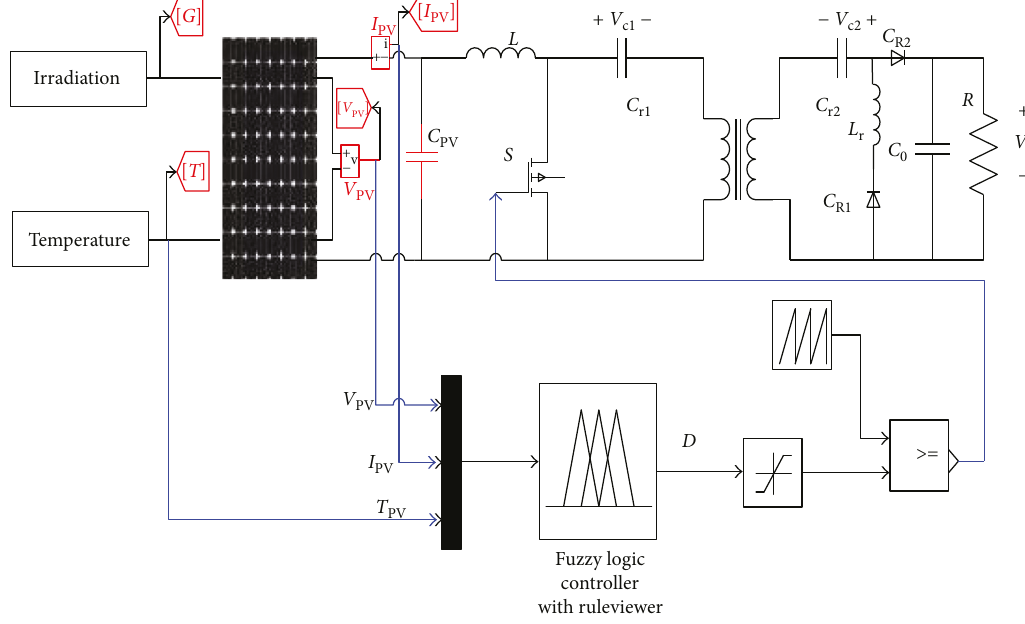
Figure 14: ANFIS-based MPPT system used for